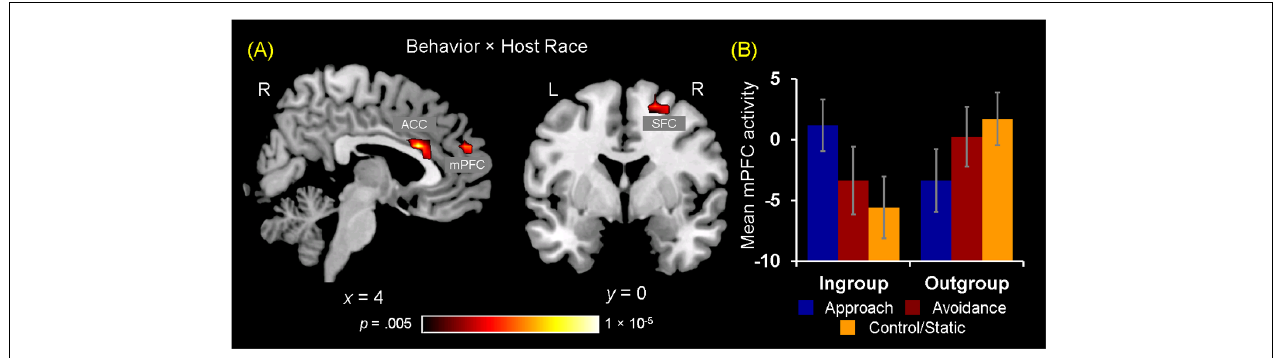
FIGURE 4 | Brain regions showing differential activations to observing ingroup vs. outgroup social encounters. (A) A significant 3 (Behavior) × 2 (Host Race) ANOVA interaction effect was identified in a set of regions, including the medial prefrontal cortex (mPFC), anterior cingulate cortex (ACC), and right superior frontal cortex (SFC). (B) Mean parameter estimates extracted from the mPFC cluster showing a significant Behaivor × Host Race interaction revealed that the effect was primarily driven by significantly decreased activity for observing ingroup static behaviors compared to ingroup approach and outgroup static behaviors. These opposing patterns of activation linked to observing ingroup vs. outgroup social encounters were similarly observed for the ACC and SFC clusters (see Supplementary Figure S4B). Error bars indicate the standard error of the mean for each condition.